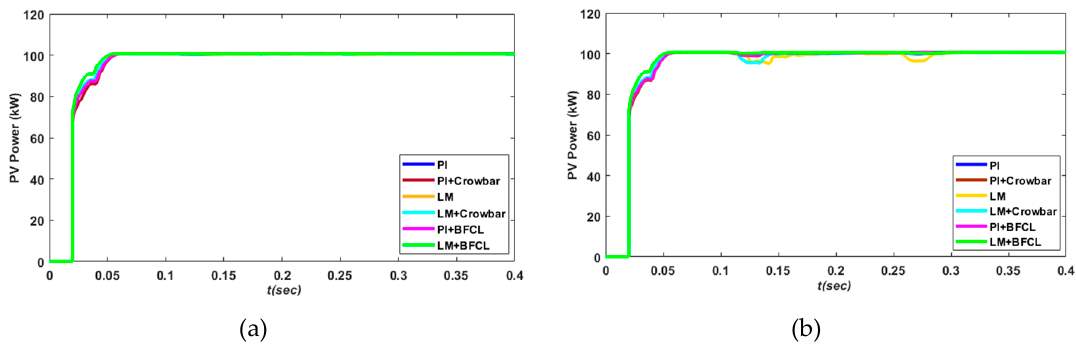
Figure 19. PV array power during the P-G fault 19( a ) and the P-P fault 19( b ) at PCC.